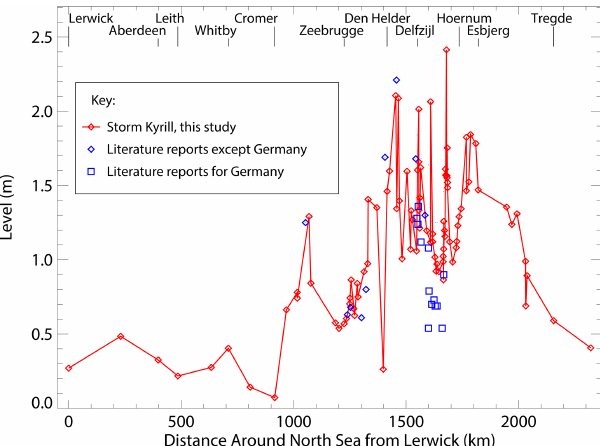
Figure 7. Skew surge during storm Storm Kyrill on 18–19 Jan- uary 2007. The values are calculated from tide gauge records and arranged by counter-clockwise distance around the North Sea start- ing from Lerwick in Scotland. Literature reports are included for